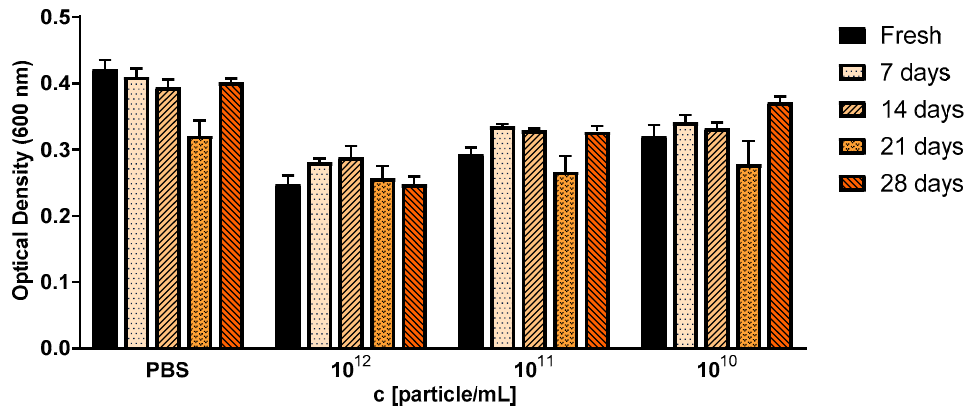
Figure 5. Antibacterial activity of Cbv34 OMVs against E. coli DH5-alpha right after isolation (fresh), and upon storage at 4 °C for 7, 14, 21 and 28 days. The treatment was done for 18 h at 37 °C. Mean ± SEM, n = 3.